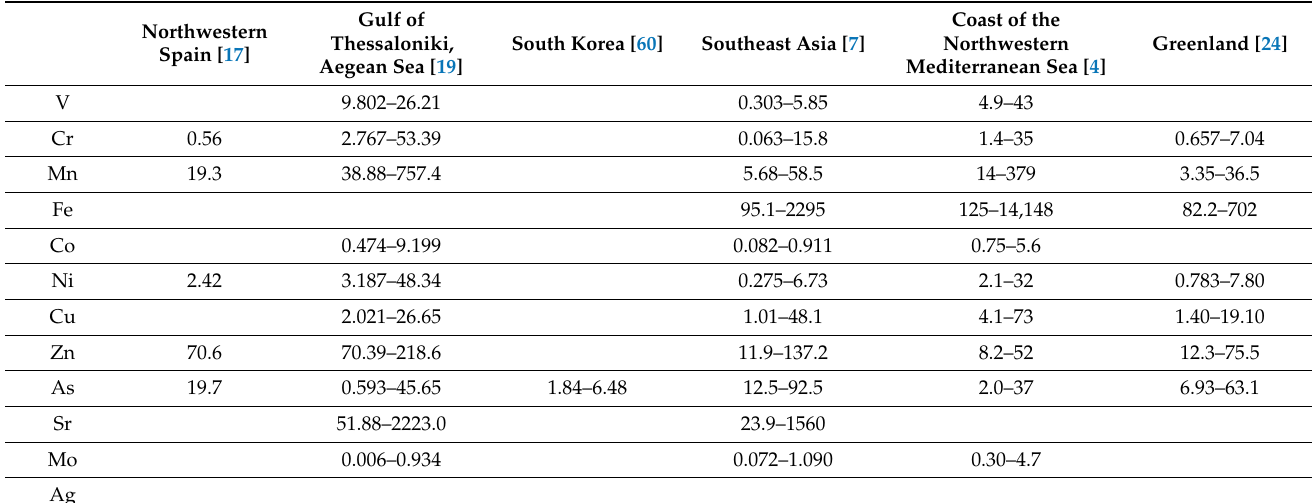
Table 4. Concentrations of the heavy metals in seaweed species at different geographical locations measured by ICP-MS. All values are in µ g/g dry weight. The following data show the range of minimum and maximum values where